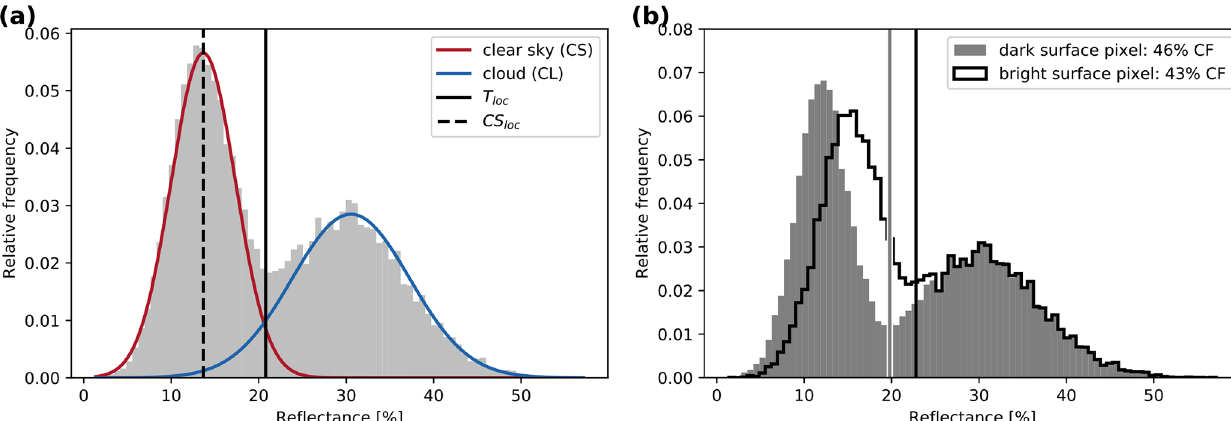
Figure 1. (a) Conceptional distribution of a bimodal distribution of HRV pixel counts for one SZA bin and one pixel within the study region during November 2004–2019. The first and second components of the Gaussian mixture model present clear (red) and cloudy conditions (blue) with the local clear-sky reflectance CS loc (vertical dashed black line) and a potential clear-cloud threshold T loc (vertical black line). Clear-sky reflectance is defined as the maximum count per histogram bin (maxbin) of the CS GMM component. The histogram minimum would be a potential threshold to separate the near-Gaussian distributions of clear and cloudy pixels for this time and location. Panel (b) is the same as (a) over a bright and a dark surface with the corresponding cloud fraction (CF). Both figures are created with three randomly generated Gaussian distributions: a distribution for the cloudy conditions and two distributions for surfaces of different brightness (Sect. 3.2), showing the surface-brightness-driven shift in the threshold that leads to different estimates of cloud fraction in this artificial example.